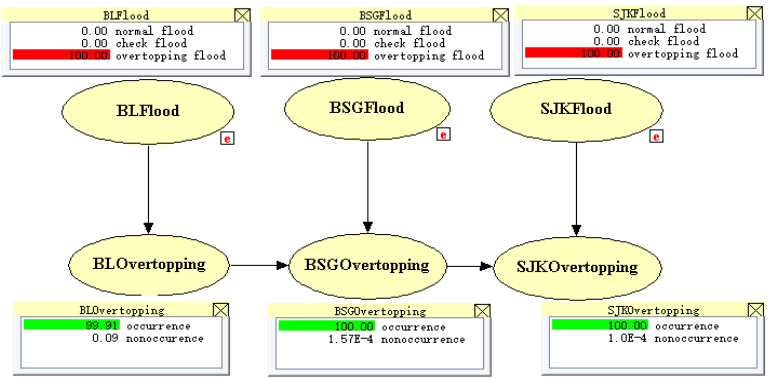
Figure 7. The inference result of continuous breaking failure path 0.